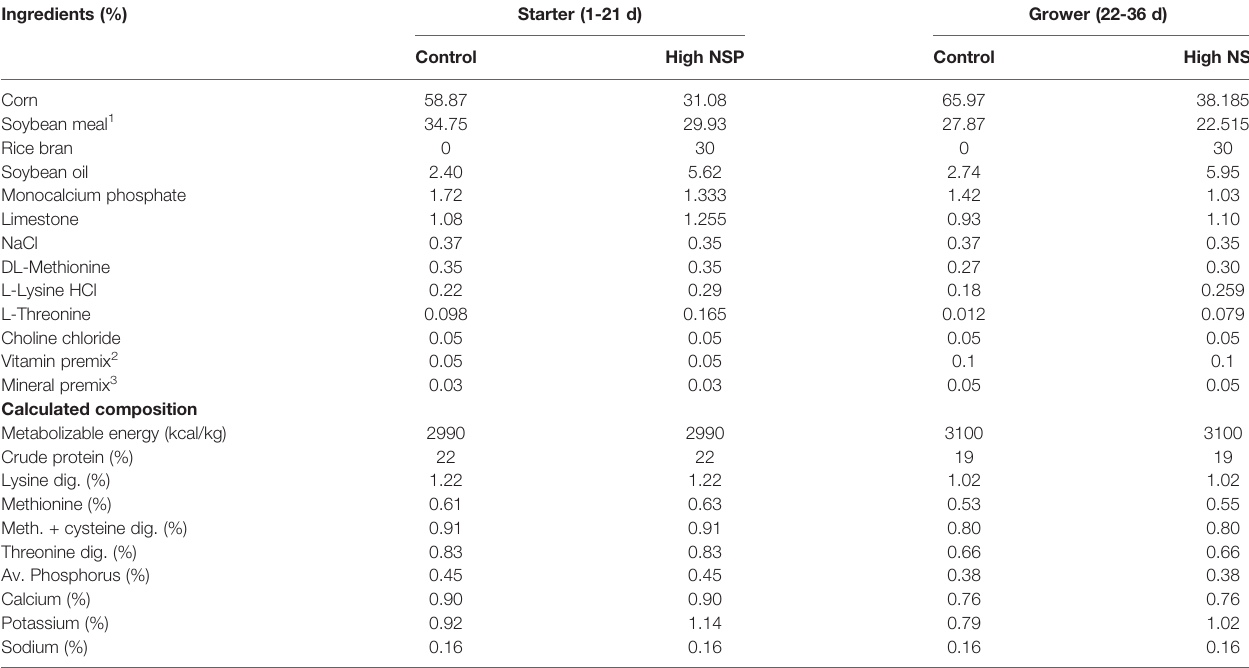
TABLE 2 | Ingredients and calculated nutritional composition of experimental diets.